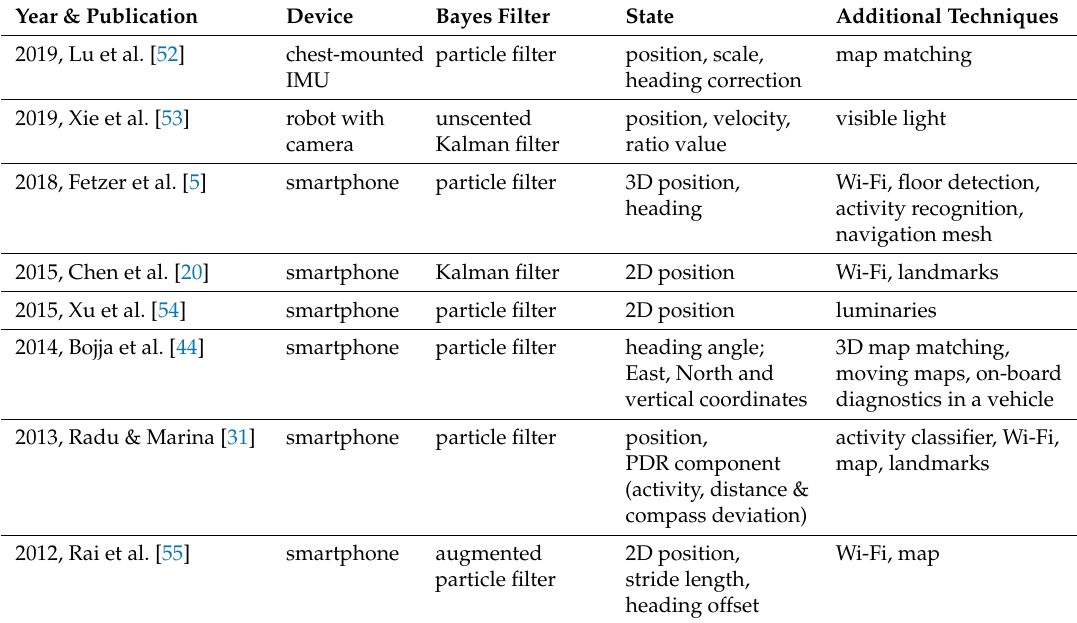
Table 1. A comparison of a few selected indoor positioning systems in terms of considered device, Bayesian filtering implementation, state representation, and other techniques applied to increase the localization accuracy.